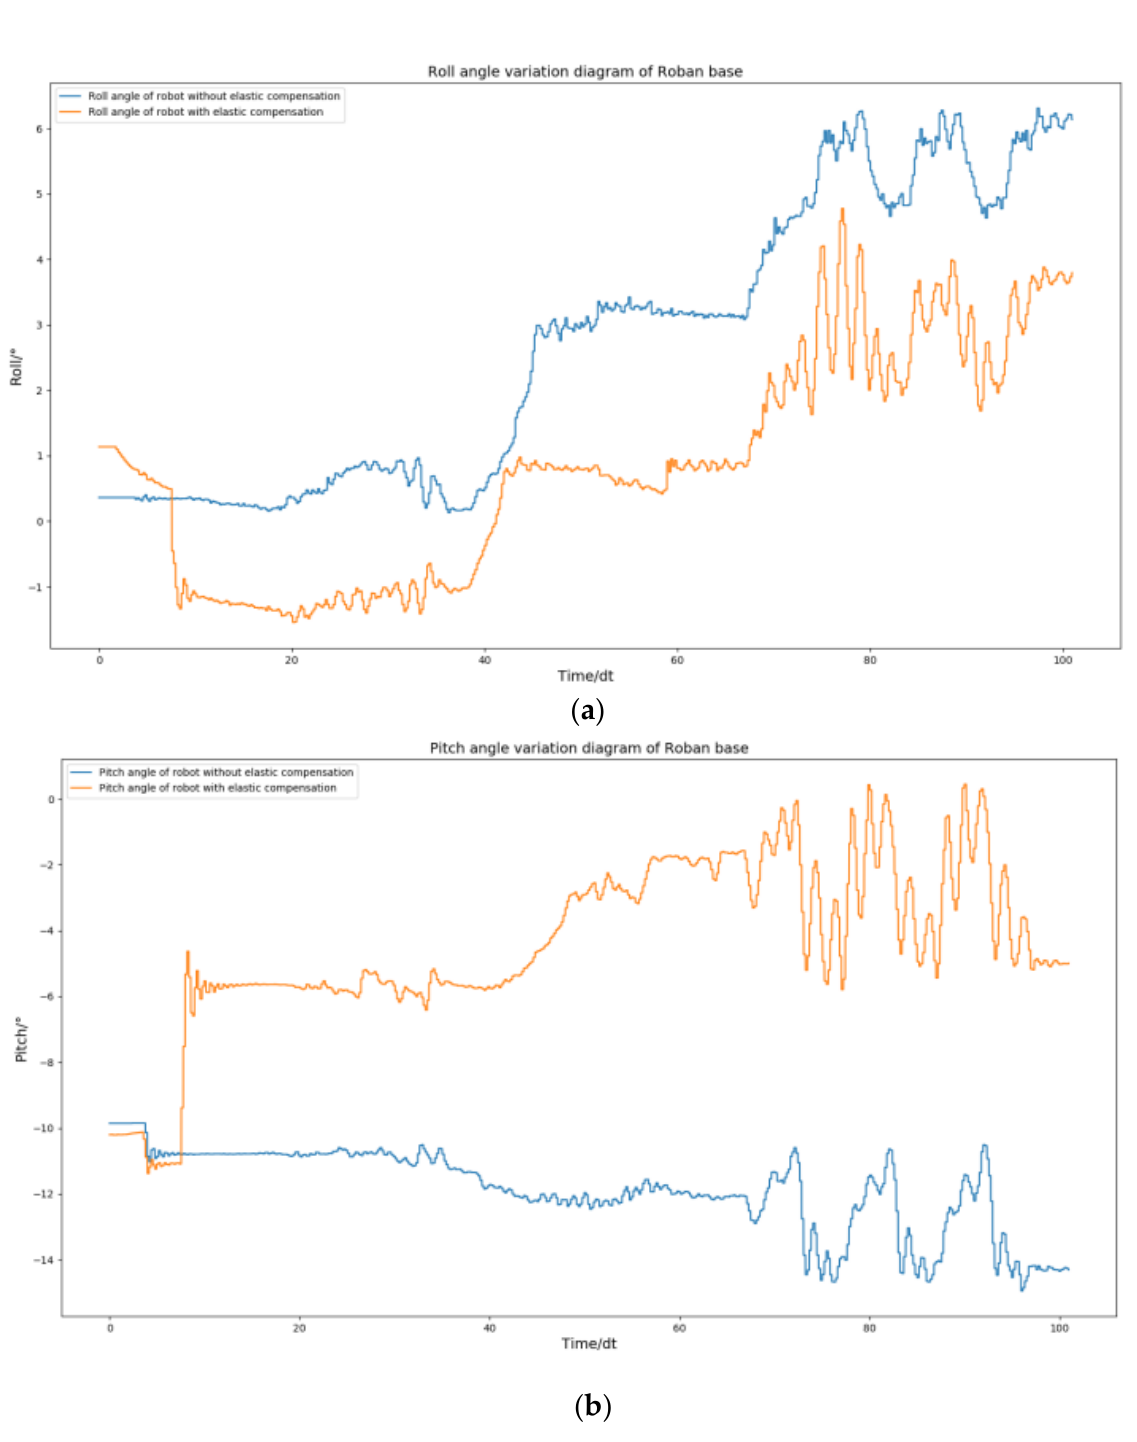
Figure 15. When Roban’s COM moves 5 cm, it completes three squats on a single leg. The comparison chart displays the roll angle and pitch angle with and without spring compensation. ( a ) Comparison diagram of roll angle change of robot with and without spring compensation. ( b ) Comparison diagram of pitch angle change of robot with and without spring compensation.